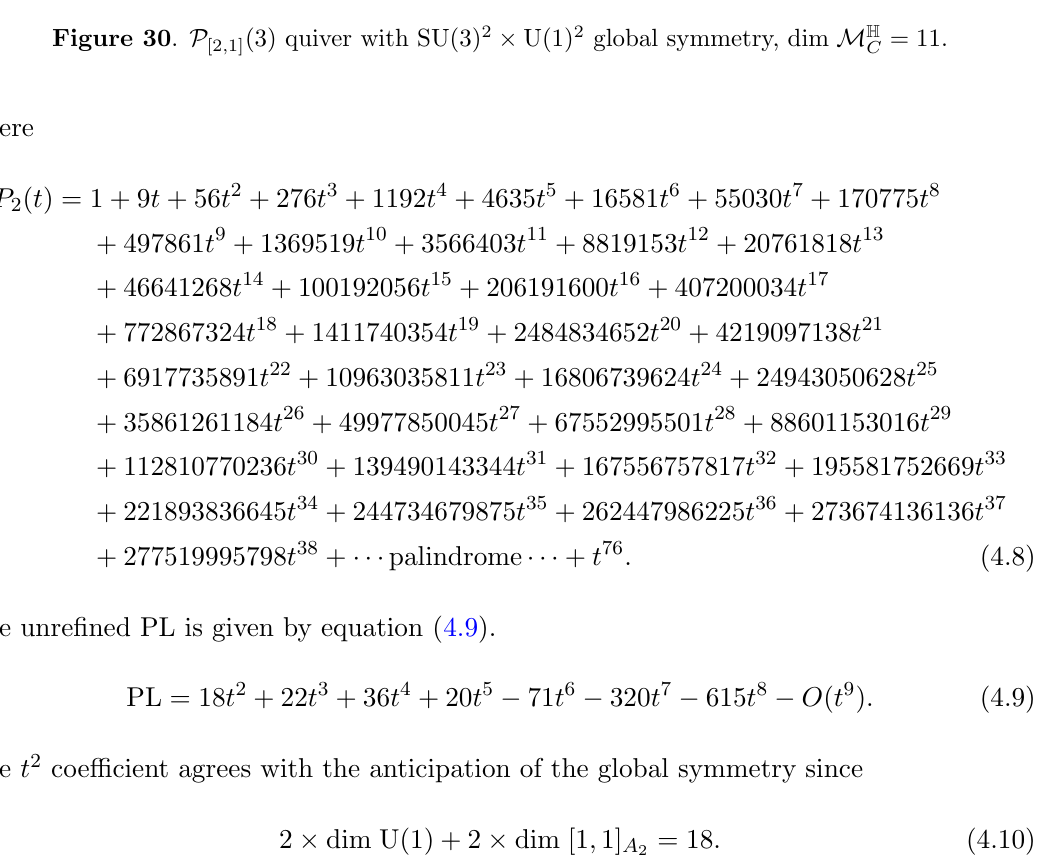
Figure 30 . P (3) quiver with SU(3) 2 (cid:2) U(1) 2 global symmetry, dim M H [2 ; 1]